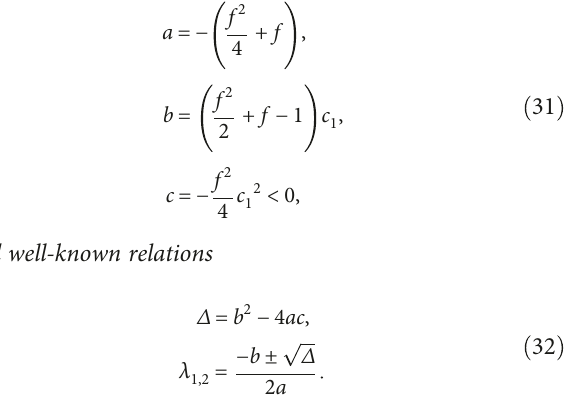
Figure 1: The eigenvalues of the matrix A on the z